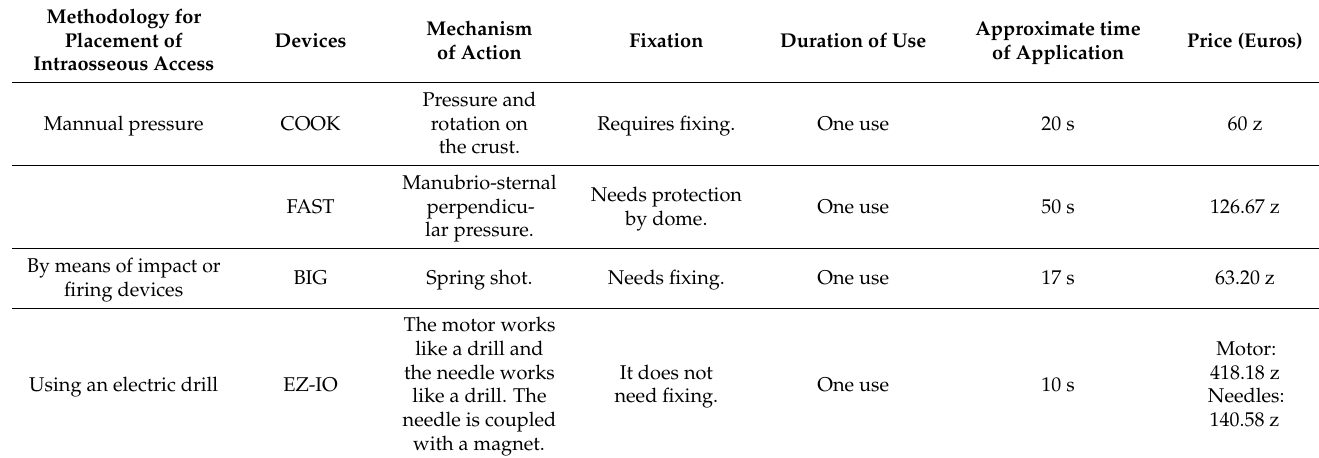
Table 2. Differences between intraosseous access